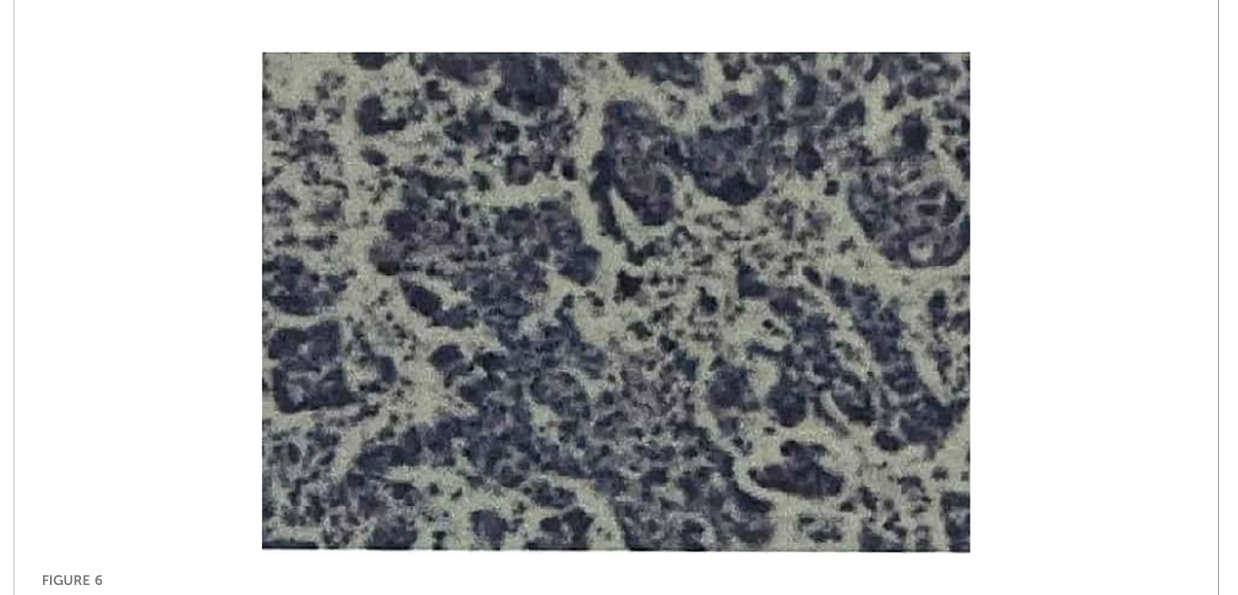
FIGURE 6 Postoperative pathology (Heart)HE ×